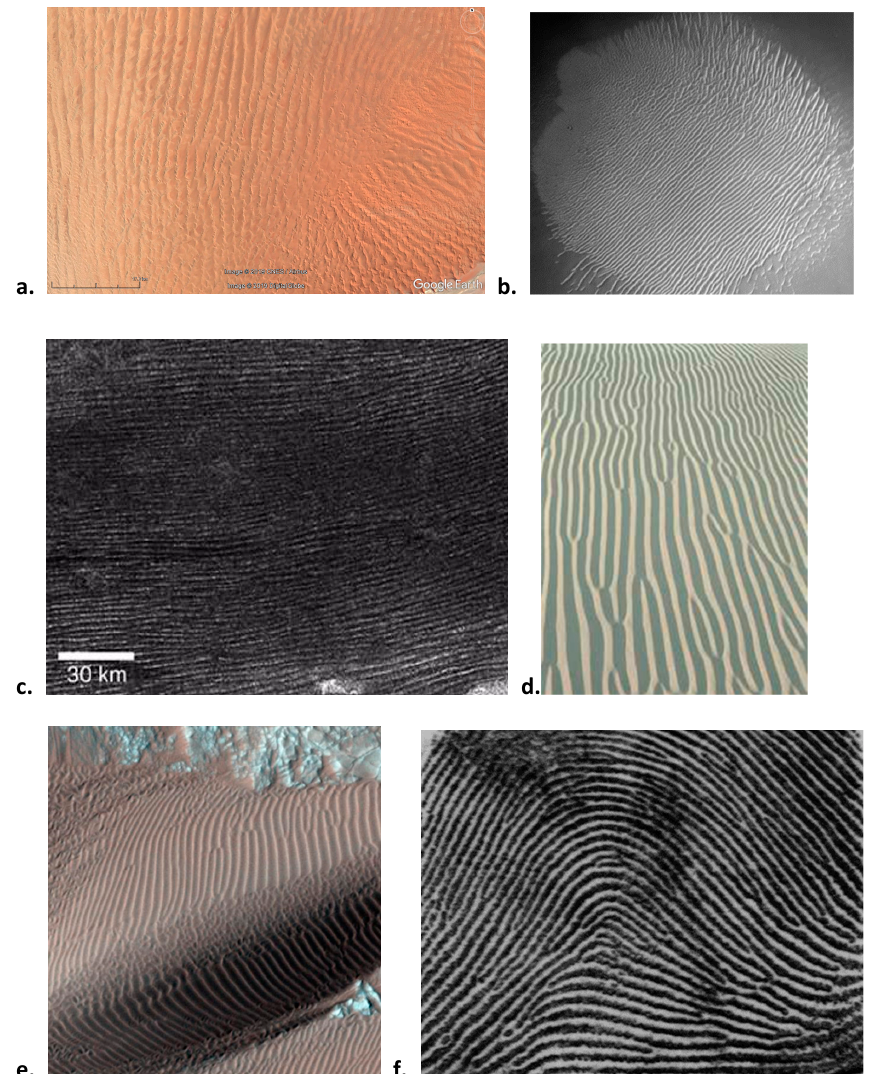
Figure 1. Dune crest and fingerprint ridgeline forms. a. Linear dunes Namib Desert − 24.43 15.17, b. Transverse Aeolian Ridges (TARS) on Mars (Image ESP_036397_1785) c. Linear dunes on Titan (Cassini T8 flyby, Oct. 2005, 8 ◦ S, 264 ◦ W, ~ 300 m resolution). d. Perspective view of ripples on larger dune slope facet (1 cm resolution) from a digital handheld camera. Note crest bifurcations and terminations. e. Ripples on dunes Nili Patera, Mars (High Resolution Imaging Science Experiment (HiRISE) image PIA18818). f. Raw ten-print image f0444_03 from the NIST fingerprint database [41] showing arch structure, ridge organization and bifurcations, and terminations (mm